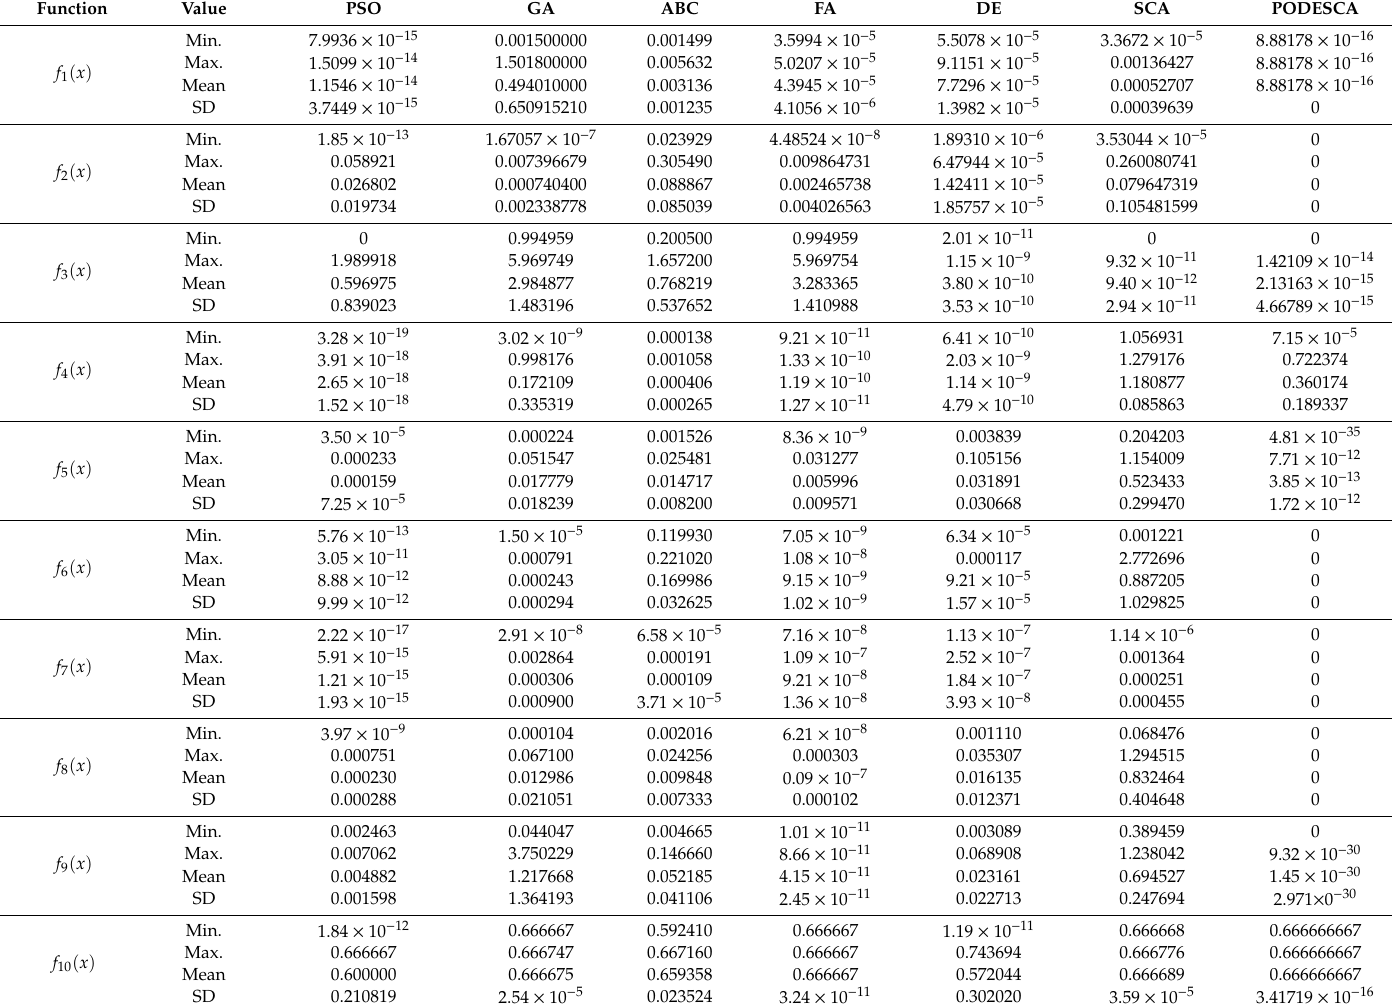
Table 2. Performance analysis of PODESCA compared to di ff erent novel